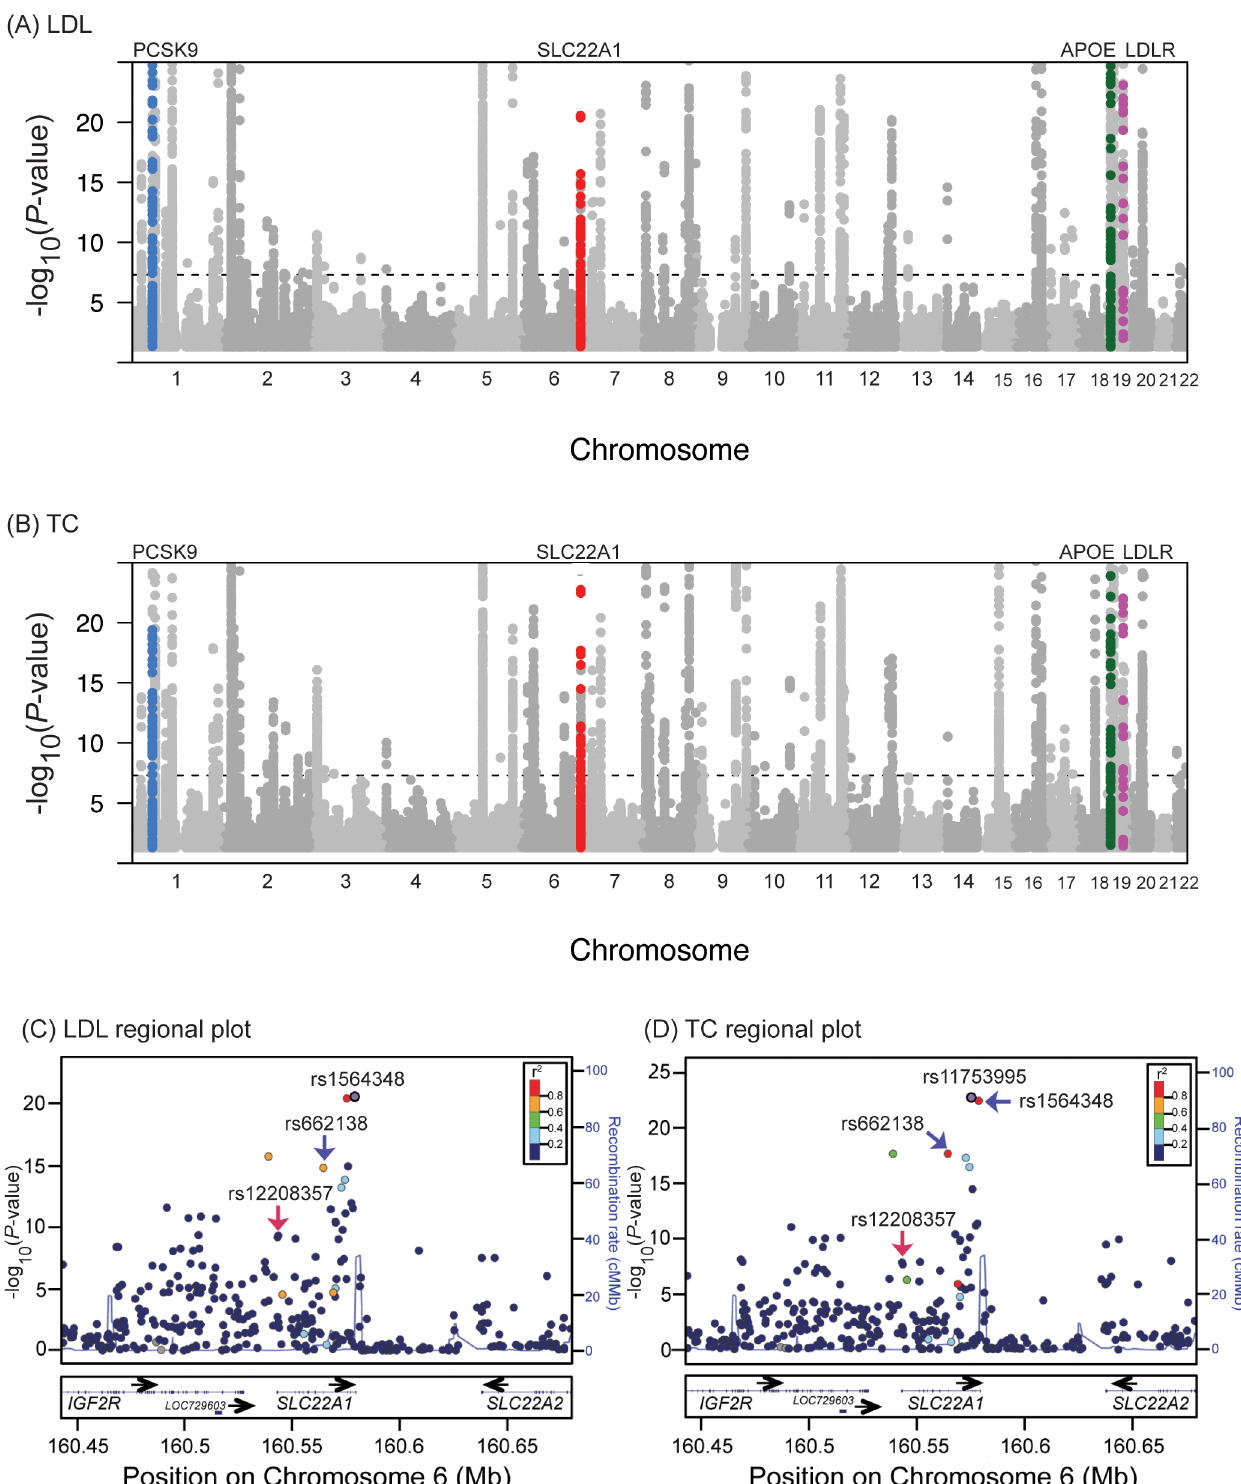
Fig 1. Manhattan plots and regional plots of the SLC22A1 locus associated with lipid levels. Manhattan plots for (A) LDL cholesterol levels and (B) total cholesterol (−log10 P) in up to 188,577 individuals with European ancestries. The data are plotted using the results available from the Global Lipids Genetics Consortium, http://csg.sph.umich.edu/abecasis/public/lipids2013/ [3]. Only the SNPs with p -value ranges from 0.05 to 1 × 10 −25 are plotted in (A) and (B). S1 Fig shows the Manhattan plots for all SNPs. APOE , PCSK9 ,and LDLR are among the genes previously known to associate with lipid levels, as highlighted